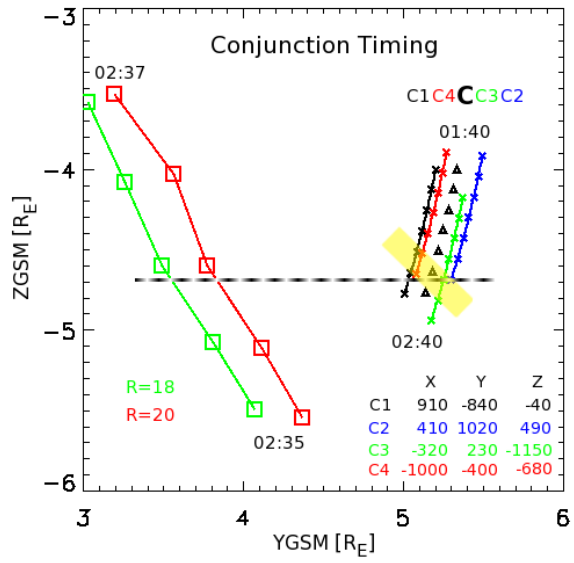
Fig. 12. Tail footprint of FAST, in the ( Y GSM ,Z GSM ) plane, to- gether with the projections of the four Cluster spacecraft and of the tetrahedron mass center. The FAST footprint, found by using the T96 model, is shown for both 18 R E and 20 R E , in order to pro- vide an approximate measure for the mapping uncertainties. The FAST footprint is shown with squares, every 30s, while the Cluster traces are marked with “x” every 10min. The mass center of the Cluster tetrahedron is indicated with triangles. The spacecraft coor- dinates relative to the tetrahedron mass center (in km) are given in the lower right corner. The conjunction with SC1 is indicated with dashed horizontal line. The shaded area shows roughly the CGR projection near Cluster, as inferred from the generator signatures on SC1 and